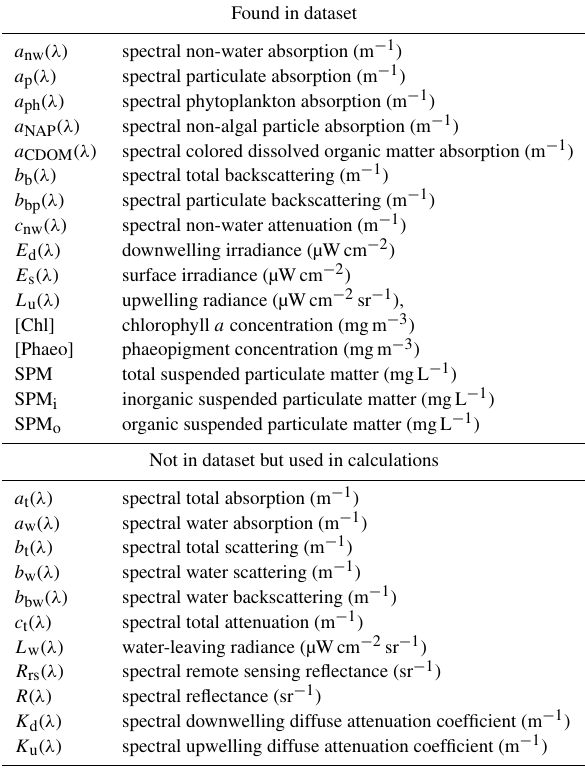
Table 1. Summary of